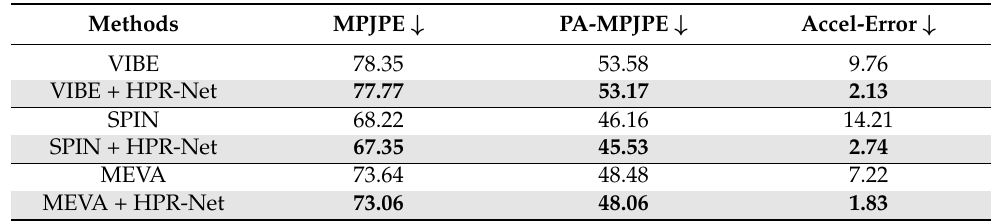
Table 6. HPR-Net’s pose refinement performance for various existing methods on Human3.6M test data. Bold values indicate performance improvements.